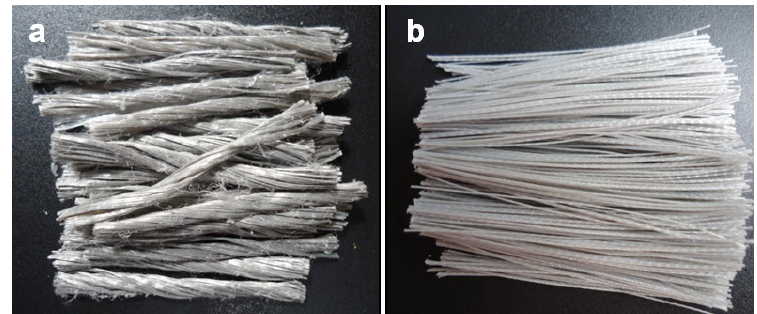
Figure 1- Macrofibre A sample a) and macrofibre B sample b) (Source: Cáceres et al.,